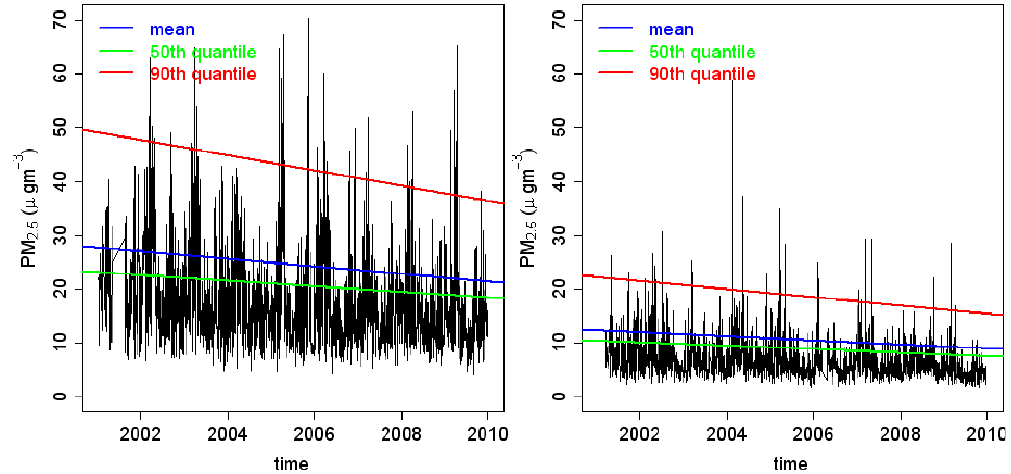
Fig. 10. Daily PM 2 . 5 time series for Illmitz (left) and Penausende (right). The OLS, 50th quantile and 90th quantile regression lines have been added.